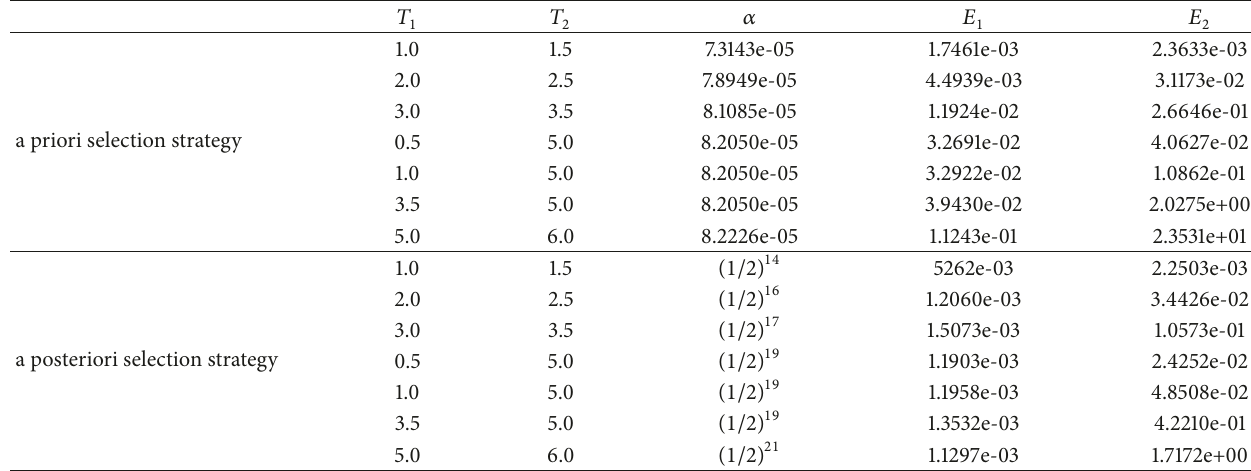
Table 3: Numerical results of Example 1 with different final time